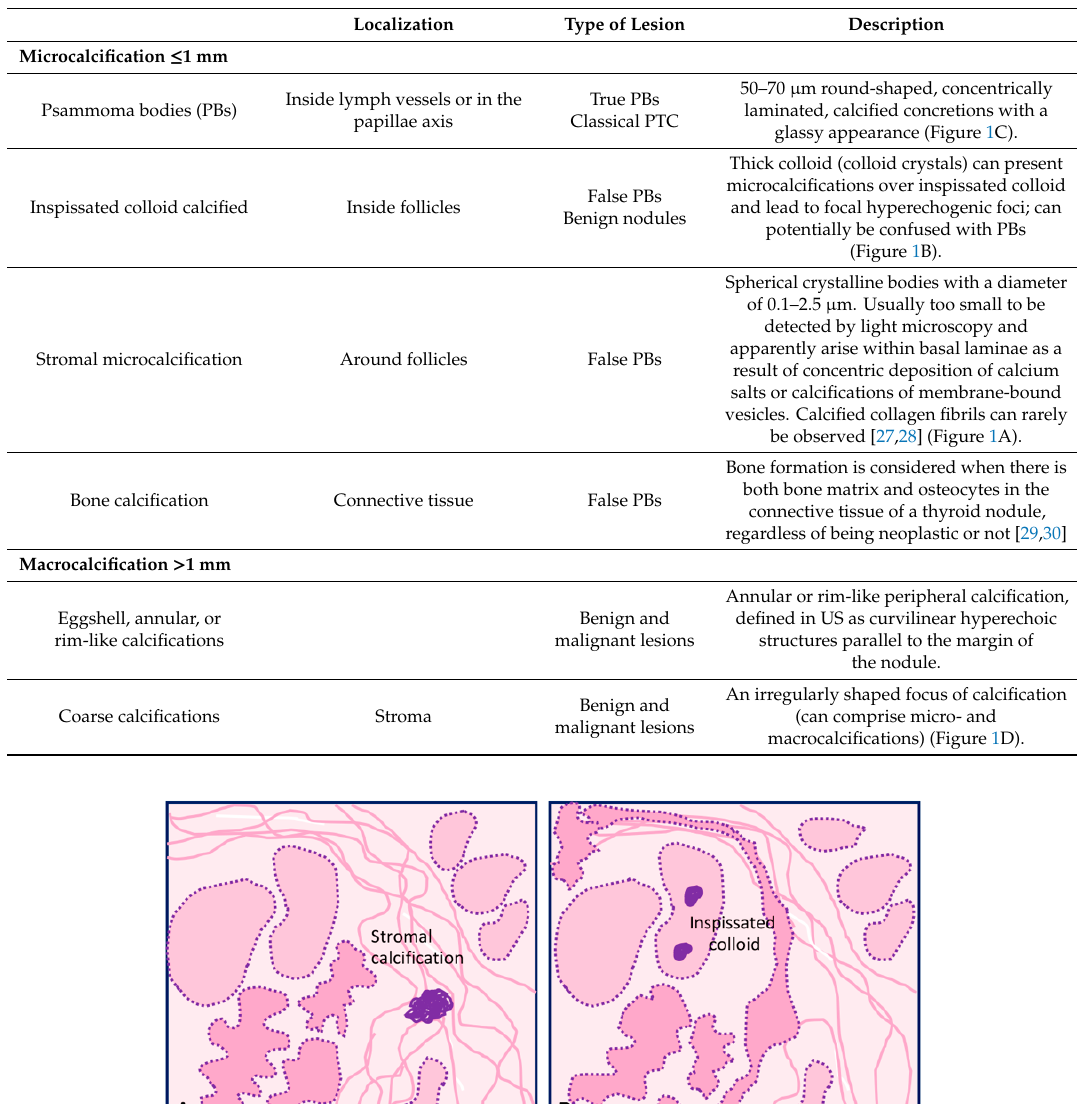
Table 1. Main types of calcification found in thyroid lesions.